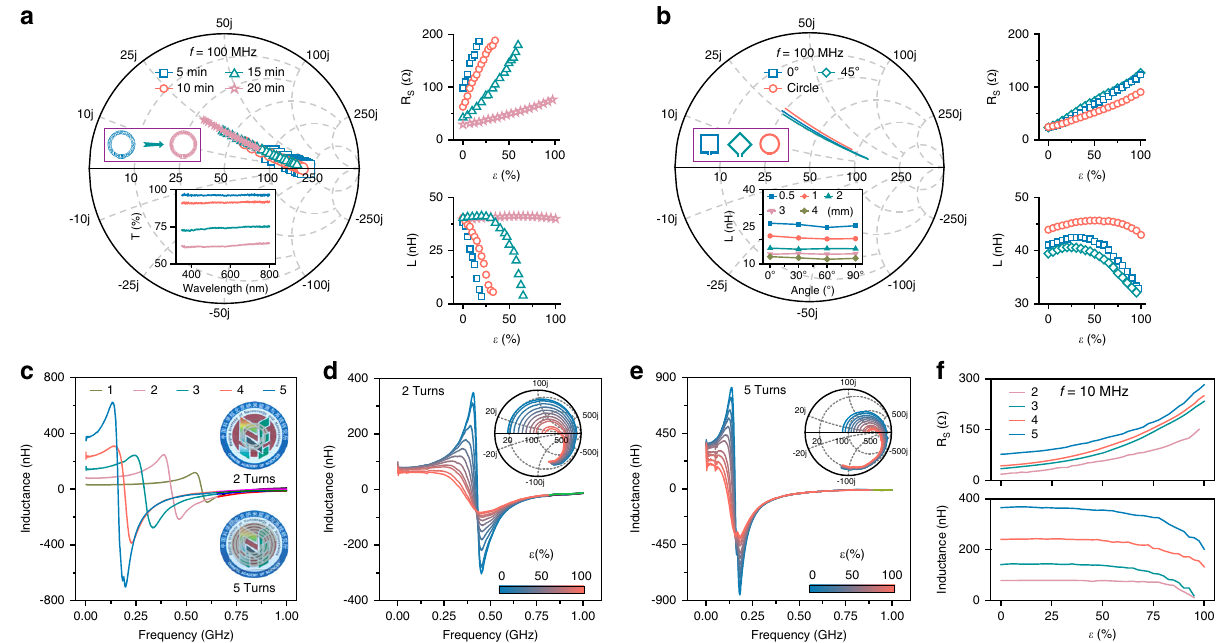
Fig. 3 Optimization of coil structure under tensile strain. a Smith chart of tensile properties for single-turn coil with four electrospinning durations. The inductance L and resistance R S are shown on the right. Insets: UV-visible spectra of Ag NFs with four electrospinning durations. b Smith chart of tensile properties of coils with different shapes. The inductance L and resistance R S are shown on the right. Insets: inductance L of unidirectional Ag NFs with different orientations. c Inductance variation versus frequency of multi-turn spiral coils. Insets: photographs of the two-turn and fi ve-turn spiral coils. Inductance variation versus tensile strain for ( d ) two-turn and ( e ) fi ve-turn spiral coils. Insets: Smith chart of two-turn and fi ve-turn spiral coils. f Inductance L and resistance R S of multi-turn spiral coils versus tensile strain at 10